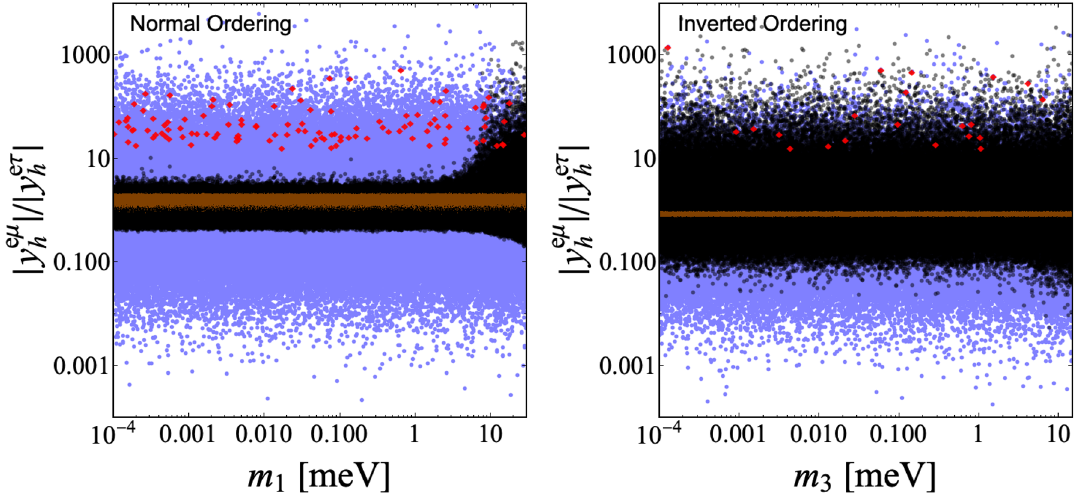
Figure 8 . Plot of the coupling ratios | y eµ The colours are the same as in figure 2.